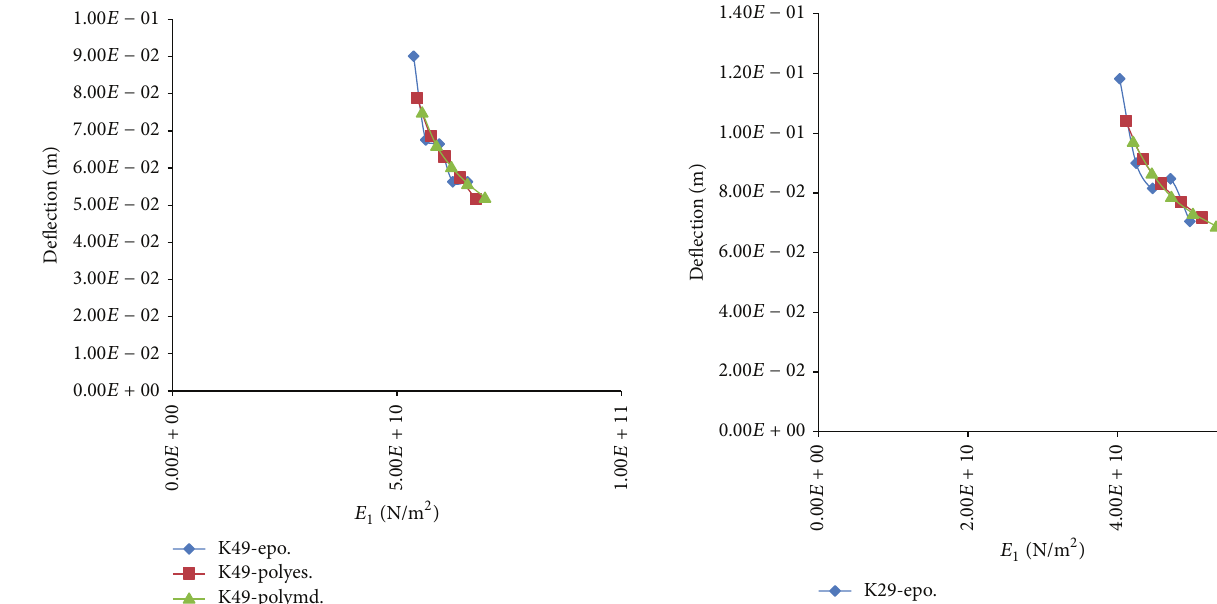
K49-epo. K49-polyes. Figure 13: Effect of longitudinal modulus of elasticity on leaf spring deflection of various composite leaf springs based on fiber type.